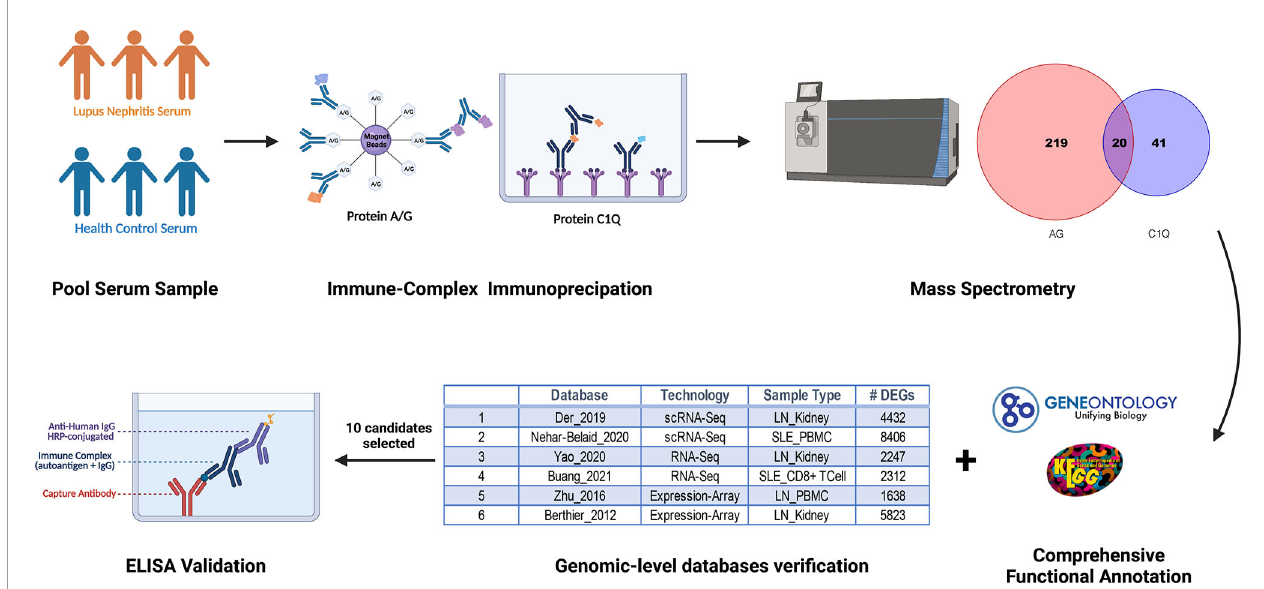
FIGURE 1 | Schematic diagram of discovery and validation of immune complex (ICx) in lupus nephritis (LN) using the immunoproteomic approach. Serum samples from patients with LN or healthy control (n =3 per group) were collected and pooled for Protein A/G or C1q-based ICx capture, followed by the identi fi cation of the proteins using mass spectrometry. Candidate ICx were further validated in a larger cohort of LN patients and healthy controls using ELISA. This fi gure was created using a graphing program from